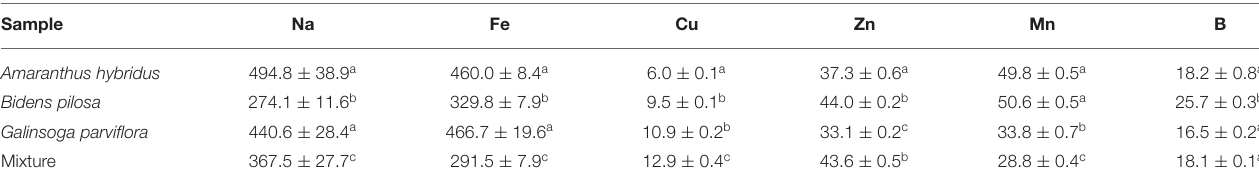
TABLE 3 | Micronutrients’ contents of lombi (mg/kg dry matter).